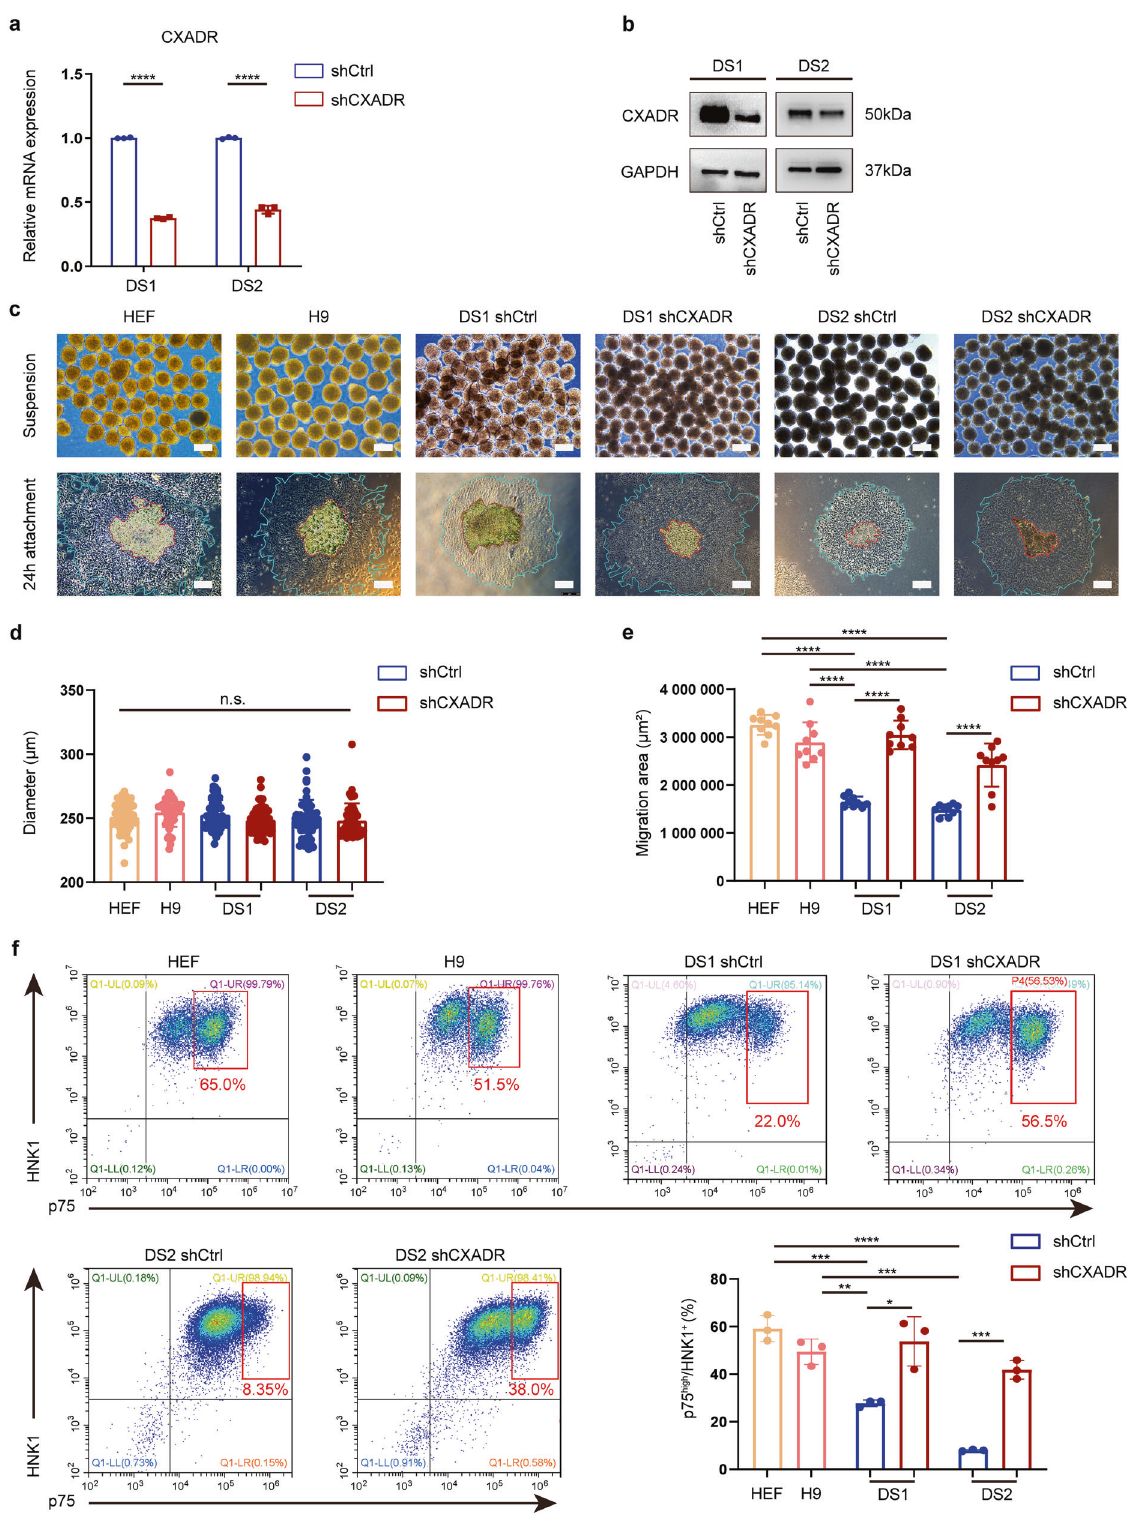
Fig. 6 Migration defects in trisomic NCSCs were ameliorated after knockdown of CXADR. a qPCR assay for CXADR expression between non-target DS control (DS shCtrl) and CXADR knockdown DS group (DS shCXADR). b The ef fi ciency of the shRNA-mediated downregulation of CXADR expression in DS-hiPSCs was assessed at the protein level. c Spheres were formed by day 7 differentiated cells derived from different groups (euploid group, DS shCtrl group, and DS shCXADR group) and then grew in attachment culture for 24 h. Scale bar: 250 μ m. d The diameter of the spheres formed by day 7 cells were calculated and compared. n = 50. e The cell migration area was quanti fi ed and compared between different groups. n = 12. f The percentage of postmigratory NCSCs (p75 high /HNK1 + ) derived from different groups was measured by FACS. n = 3. Data are presented as the mean ± SD of three independent experiments. * P < 0.05, ** P < 0.01, *** P < 0.001, **** P < 0.0001, one-way ANOVA ( d ) and two-tailed unpaired Student ’ s t test ( a , e , f ). Cell Death and Disease (2022)